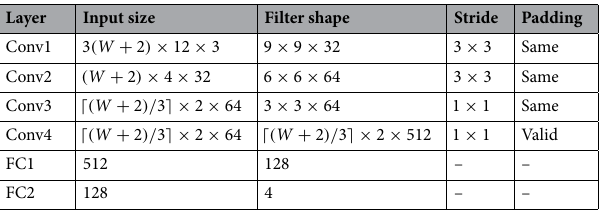
Table 1. Network architecture ( W = window size). ⌈∗⌉ denotes the ceiling function.